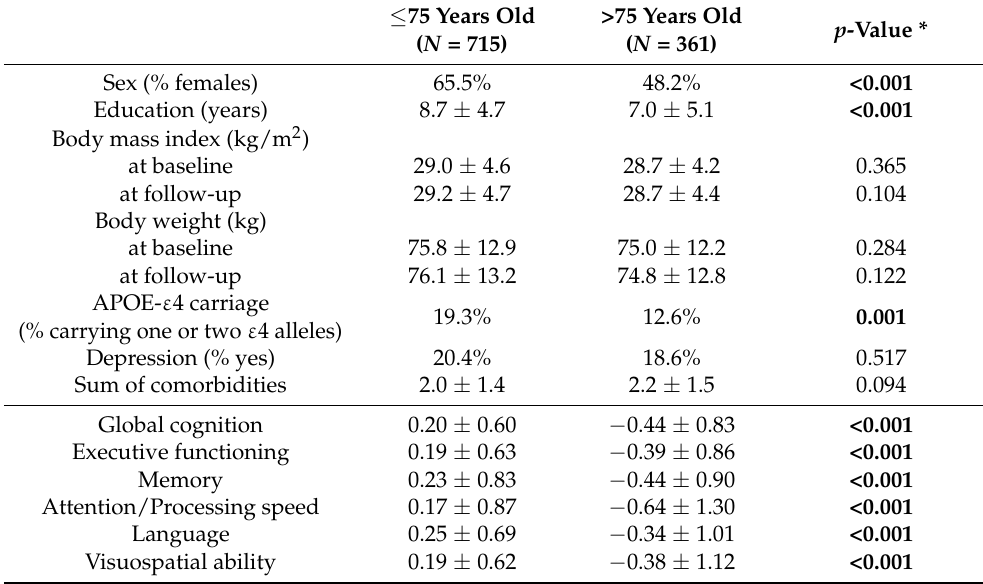
Table 1. Demographic, anthropometric, and clinical characteristics and cognitive composite scores in participants aged ≤ 75 years and >75 years. ≤ 75 Years Old ( N =